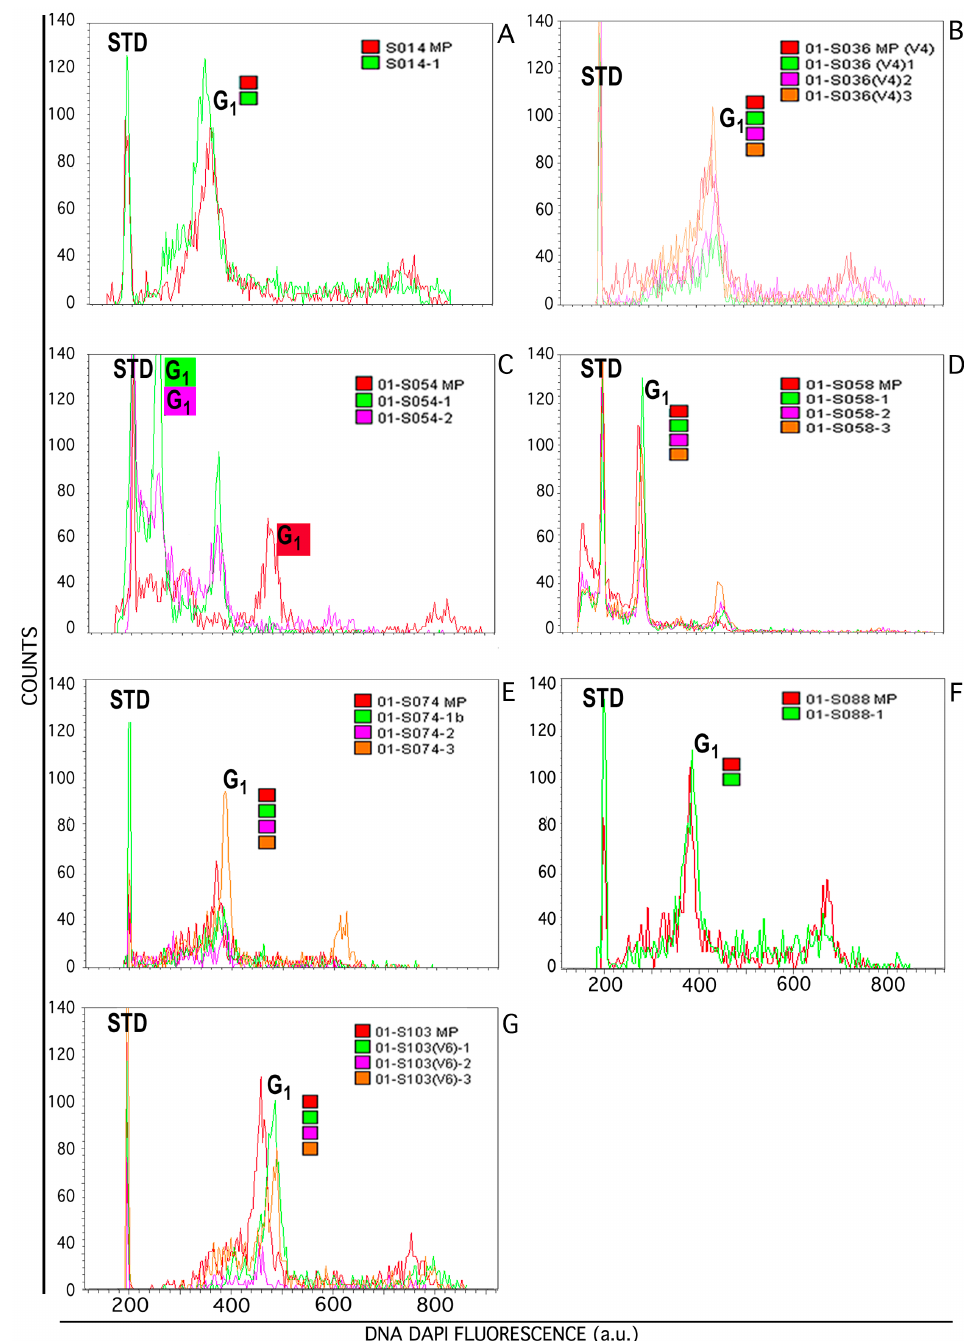
Figure 3. FCM analysis of genetic stability of Sansevieria spp. mother plant (MP) and their regenerants. DAPI DNA fluorescence histogram overlapping among MP and respective regenerants are presented. Fluorescence histograms of DAPI stained nuclei in suspension show an IRS (STD) region that contains reference beads to allow histogram comparison among several nuclei isolations from Sansevieria individuals. The G 1 region shows basic DNA content for each sample; the use of color coding refers to MP and their Rs per line/species. In the abscissa for DAPI fluorescent emission (arbitrary units) captured by a 450–45 band pass filter after violet laser excitation is shown. The panels show: ( A ) S. concinna S-CNR-014, ( B ) S. forskaoliana S-CNR-036, ( C ) S. parva S-CNR-054, ( D ) S. pearsonii S-CNR-058, ( E ) S. fasciata × forskaoliana S-CNR-074, ( F ). S. caulescens S-CNR-088, ( G ) S. elliptica S-CNR-103. The relative stability in DAPI-DNA fluorescence level, which is correlated to the nu- clear DNA amount for each mother plant and its regenerants, was calculated on cell cycle